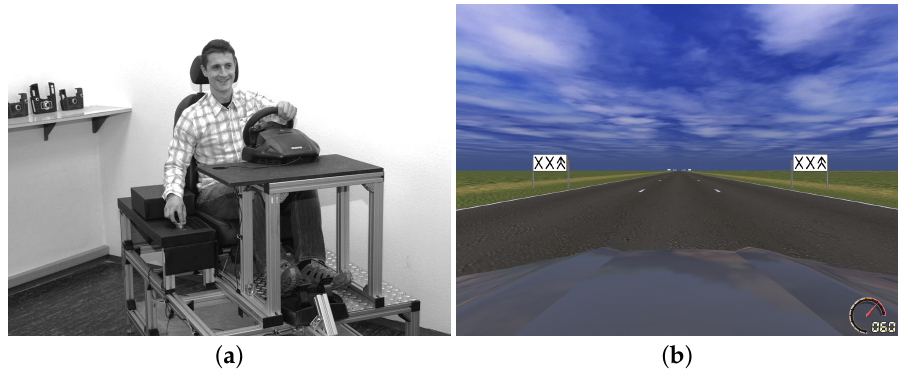
Figure 4. Seatbox with steering wheel ( a ) and screenshot of the lane change test ( b ). Monitor, headphones for acoustic shielding and haptic simulator are not shown in ( a ).